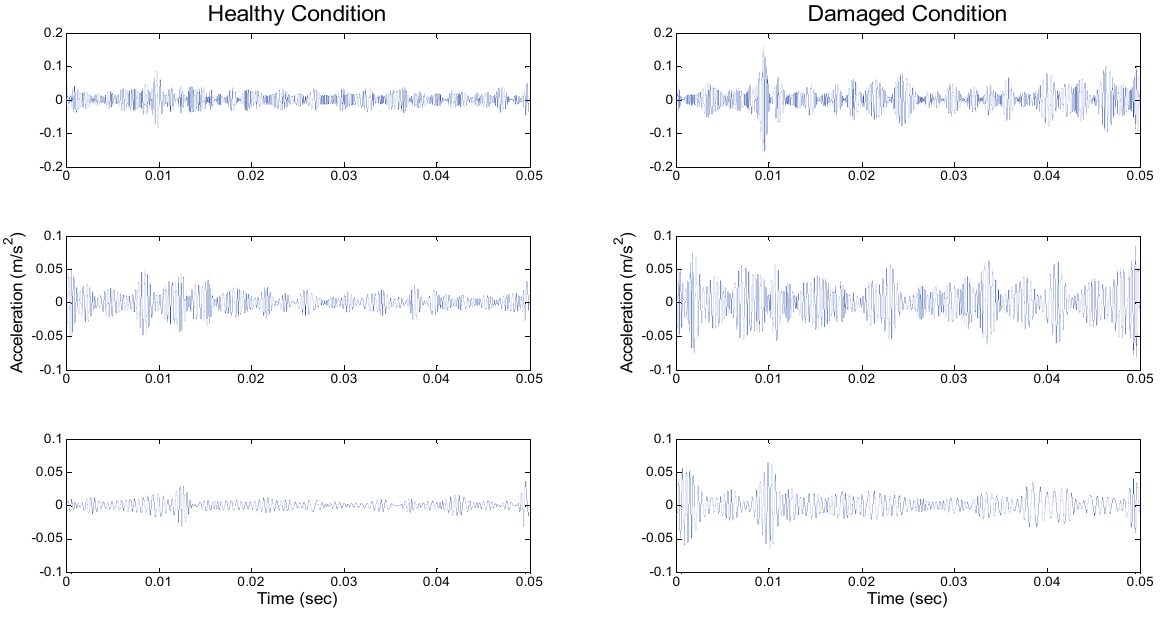
Figure 9. Profile of the collection of the first IMFs from healthy bearing acceleration: 10